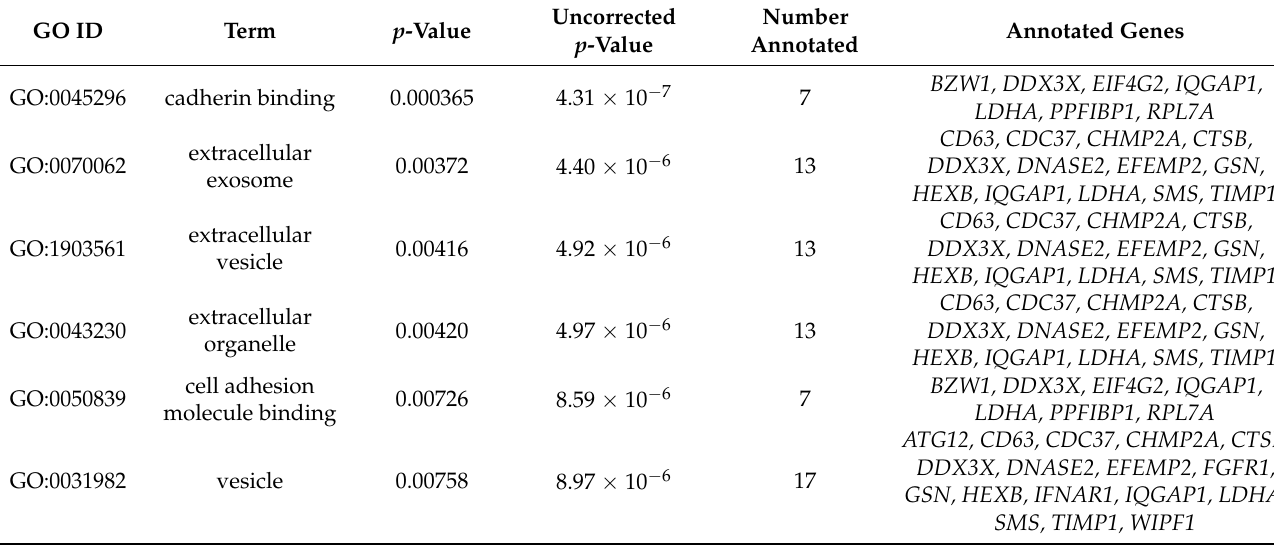
Table 2. Gene ontology (GO) analysis results of screened GSC specific 30-gene signature